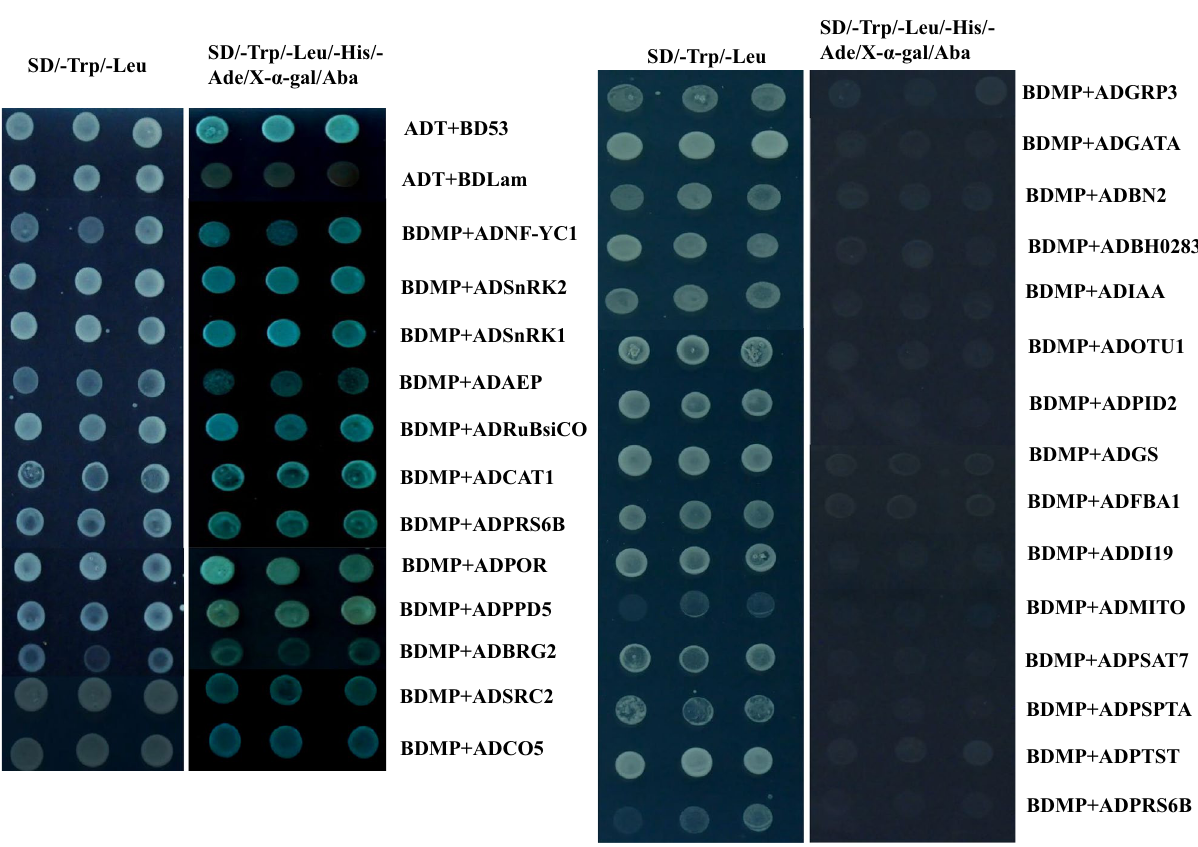
Figure 5. Verification of the interactions between 17K and 27 screened host factors. BD17K was co-transformed with each of 27 host proteins into Y2HGold yeast cells and plated on low-(SD/–Trp/–Leu)